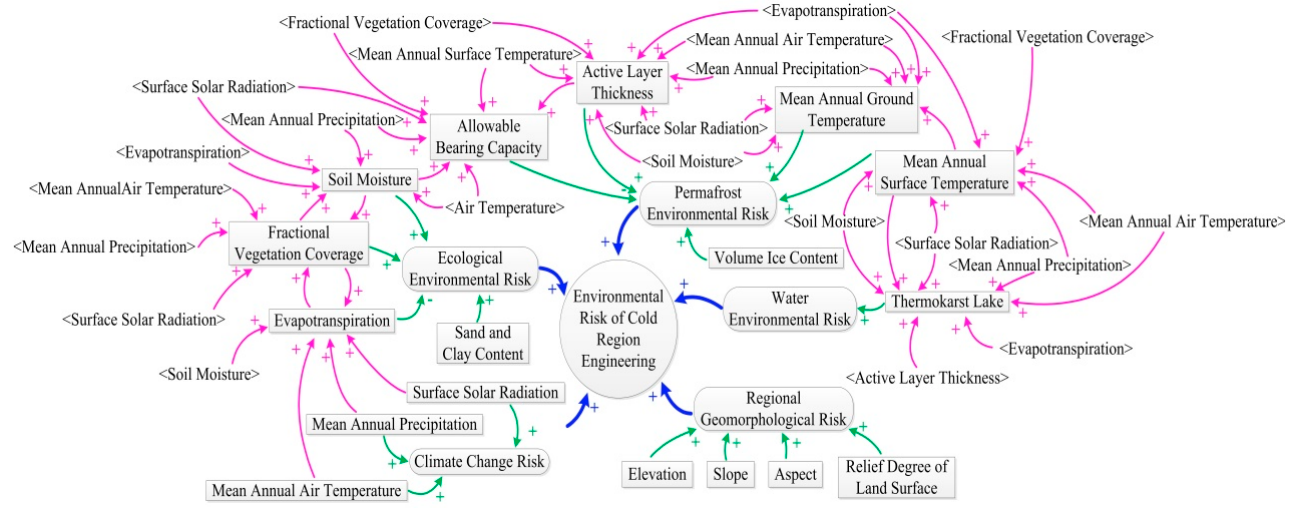
Figure 2. Risk identification model.